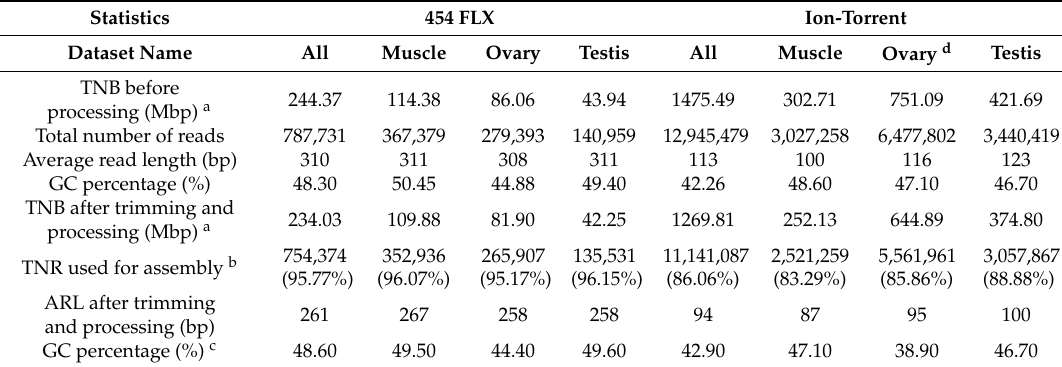
Table 1. Overview of sequencing reads and reads after